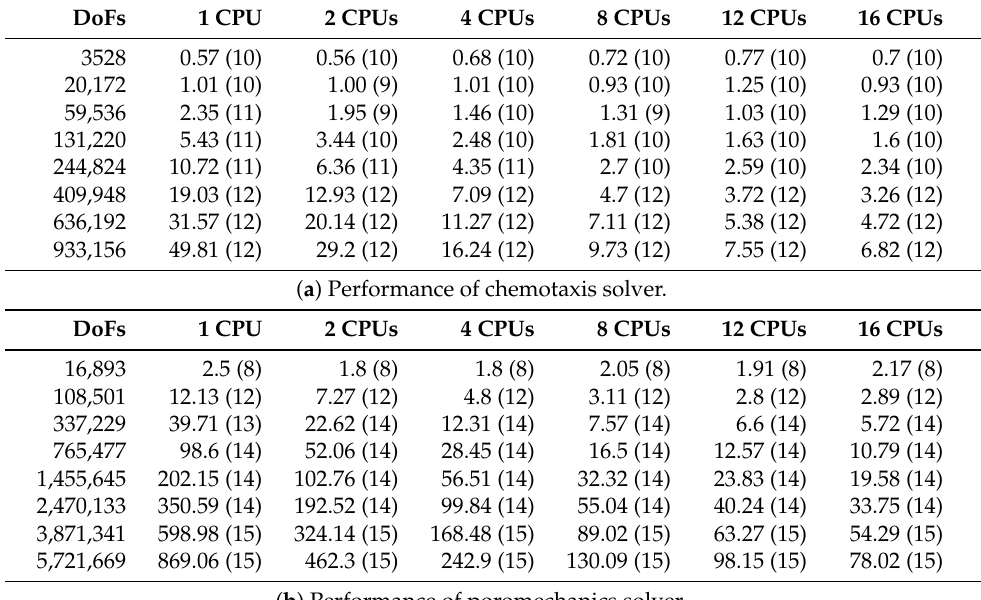
Table 3. Performance of the nonlinear solver used with the preconditioner detailed in Section 5.3. We show the total CPU time on the nonlinear solver on a single timestep, together with the maximum number of GMRES iterations in